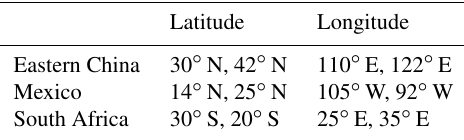
Table 1. The coordinates of each